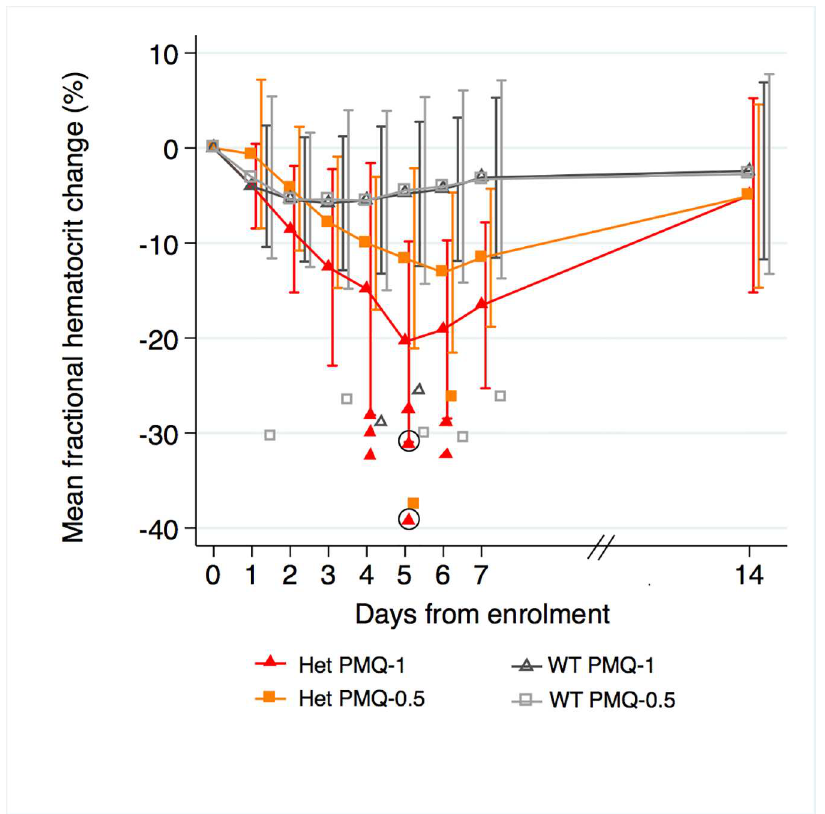
Fig 2. Mean fractional haematocrit changes over time in G6PD heterozygous and wild-type females taking PMQ-1 or PMQ-0.5. Line graph representsfractional haematocrit plotted as the mean (95% CI). Plotted shapes represent individualswith maximum fractional haematocrit reductions below − 25%. Circled shapes represent individuals who received a blood transfusion.